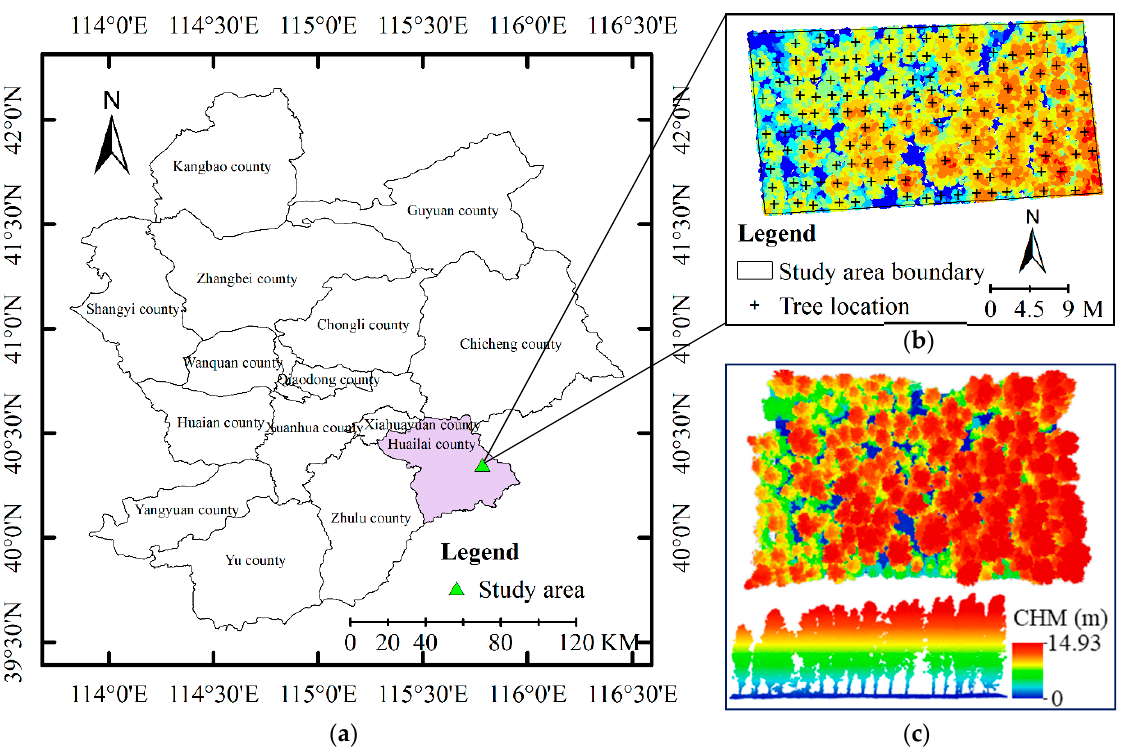
Figure 1. The geography of the study area: ( a ) study area location, ( b ) study area boundary and individual tree location, and ( c ) UAV LiDAR point data and profiles.